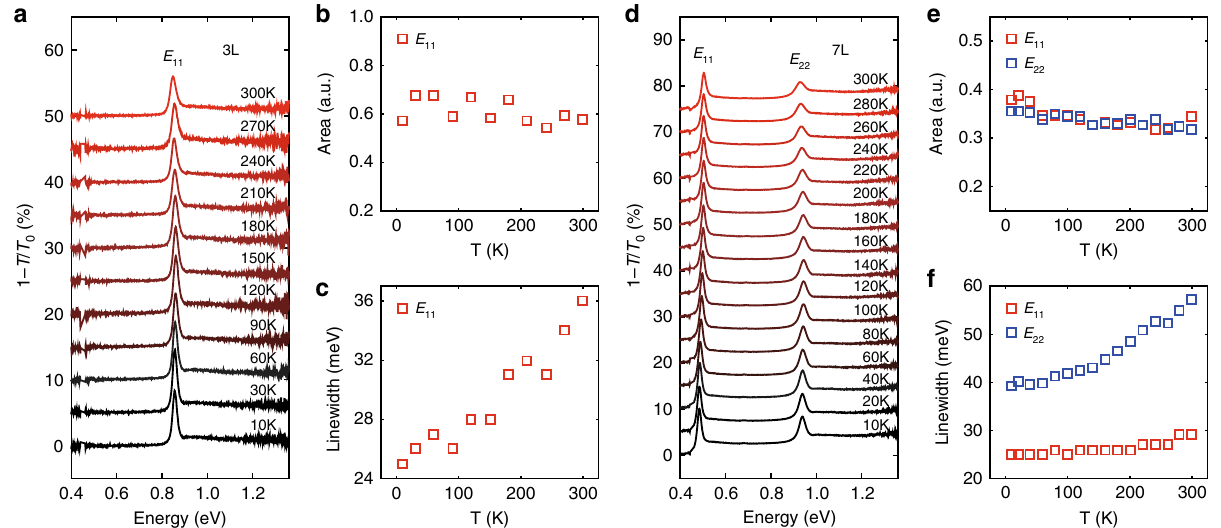
Fig. 4 Temperature dependence of the optical absorption. IR extinction spectra of a 3 L and d 7 L BP on quartz substrates at varying temperatures from 10 K to 300 K, respectively. The spectra are vertically offset for clarity. Integrated area of the exciton peaks of b 3 L and e 7 L BP as a function of temperature, respectively. Linewidth of the exciton peaks of c 3 L and f 7 L BP as a function of temperature, respectively. Data are extracted from spectral fi tting using Eq. (3) in